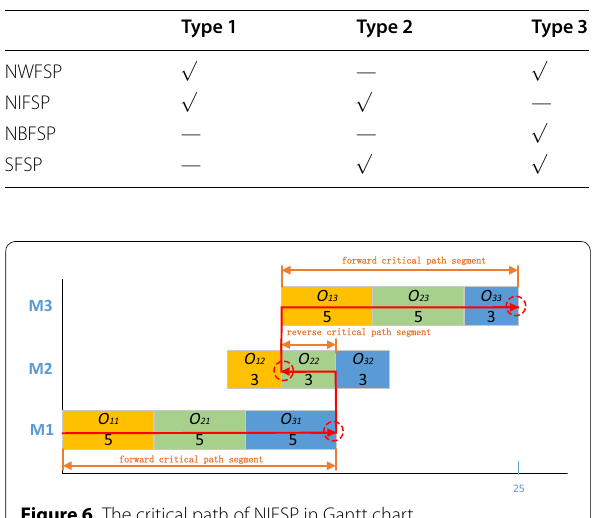
Table 1 Summarize of anomalies